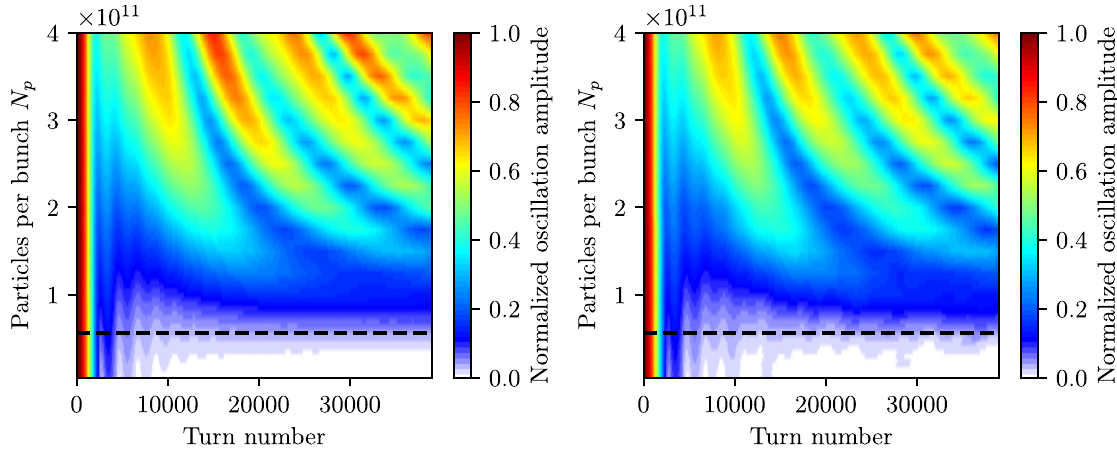
FIG. 13. Time evolution of the bunch offset amplitude (color coding) after a kick, obtained from MELODY using Eq. (62) (left) and from macroparticle simulations using BL on D (right) for different intensities (vertical axes) and a broadband impedance with Im Z=n ¼ 0 . 07 Ω , 4 GHz; zero-intensity τ 0 . 82 ns, μ ¼ 2 , and V 6 MV. The LLD threshold at ≈ 5 . 7 × 10 10 is shown with a Q ¼ 1 , and f 4 σ ¼ 0 ¼ r ¼ dashed line.